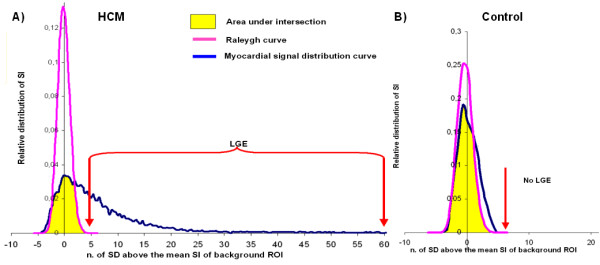
Overlapping between the Rayleigh curve and the measured curve of distribution of signal intensity in a patient with HCM and in a control. The yellow area is the intersection between the curves. The concordance between the curves was measured as the ratio between the area of intersection and the area under the Rayleigh. In HCM patients (A) the two curves were very different and LGE was defined as the myocardial signal higher than the maximal signal of the Rayleigh. In the control (B) no LGE was detected.